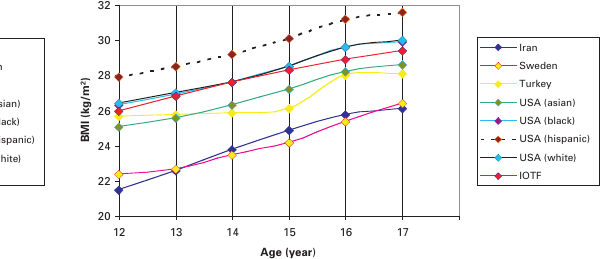
Figure 2 Comparison of the 95 th percentile of BMI values in adoles- cent boys from various parts of the world [11,